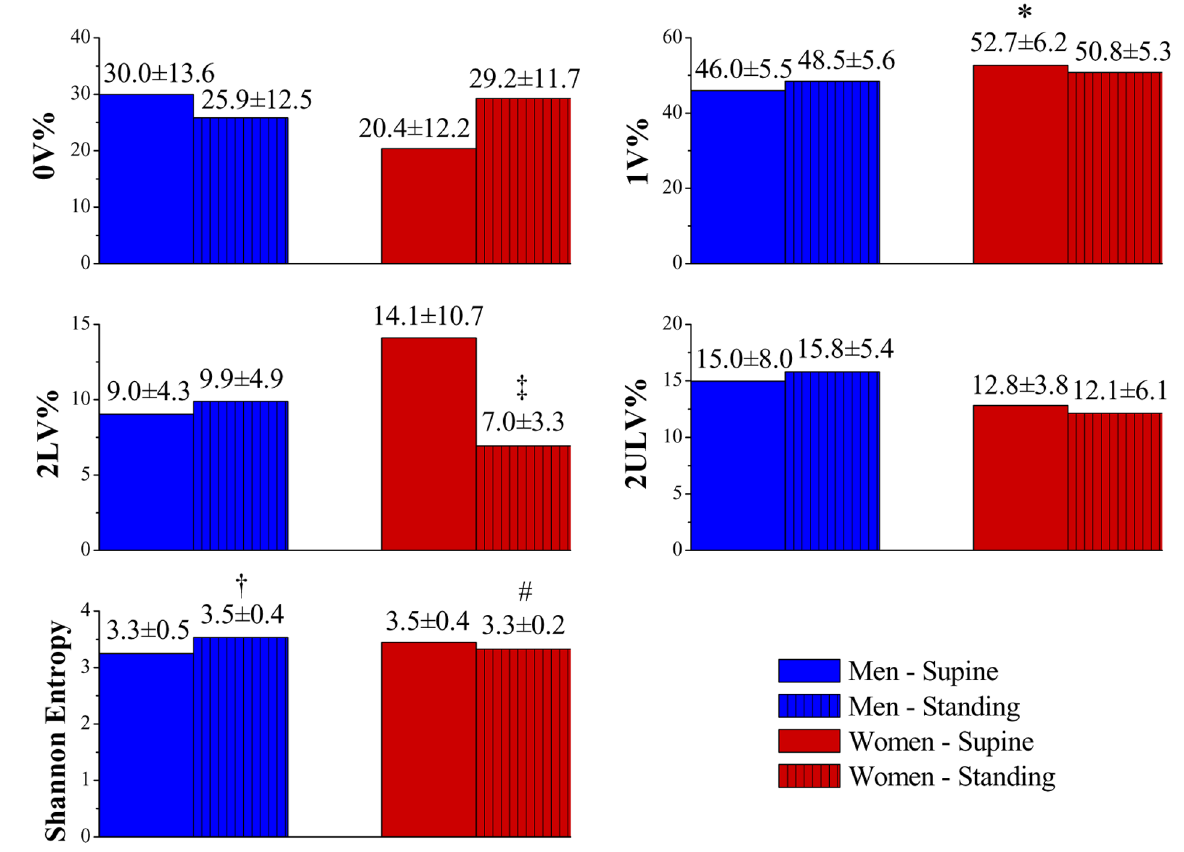
Figure 3. Heart rate variability determined by symbolic analysis in the supine and standing positions. Data are reported as means ± SD. 0V = patterns with no variations; 1V = patterns with one variation; 2LV = patterns with two like variations; 2ULV = patterns with two unlike variations. *P < 0.05 compared to men in the supine position; # P < 0.05 compared to men in the standing position; † P < 0.05 compared to men in the supine position; ‡ P < 0.05 compared to women in the supine position. Gender effect: unpaired t -test or Mann- Whitney test; position effect: paired t -test or Wilcoxon